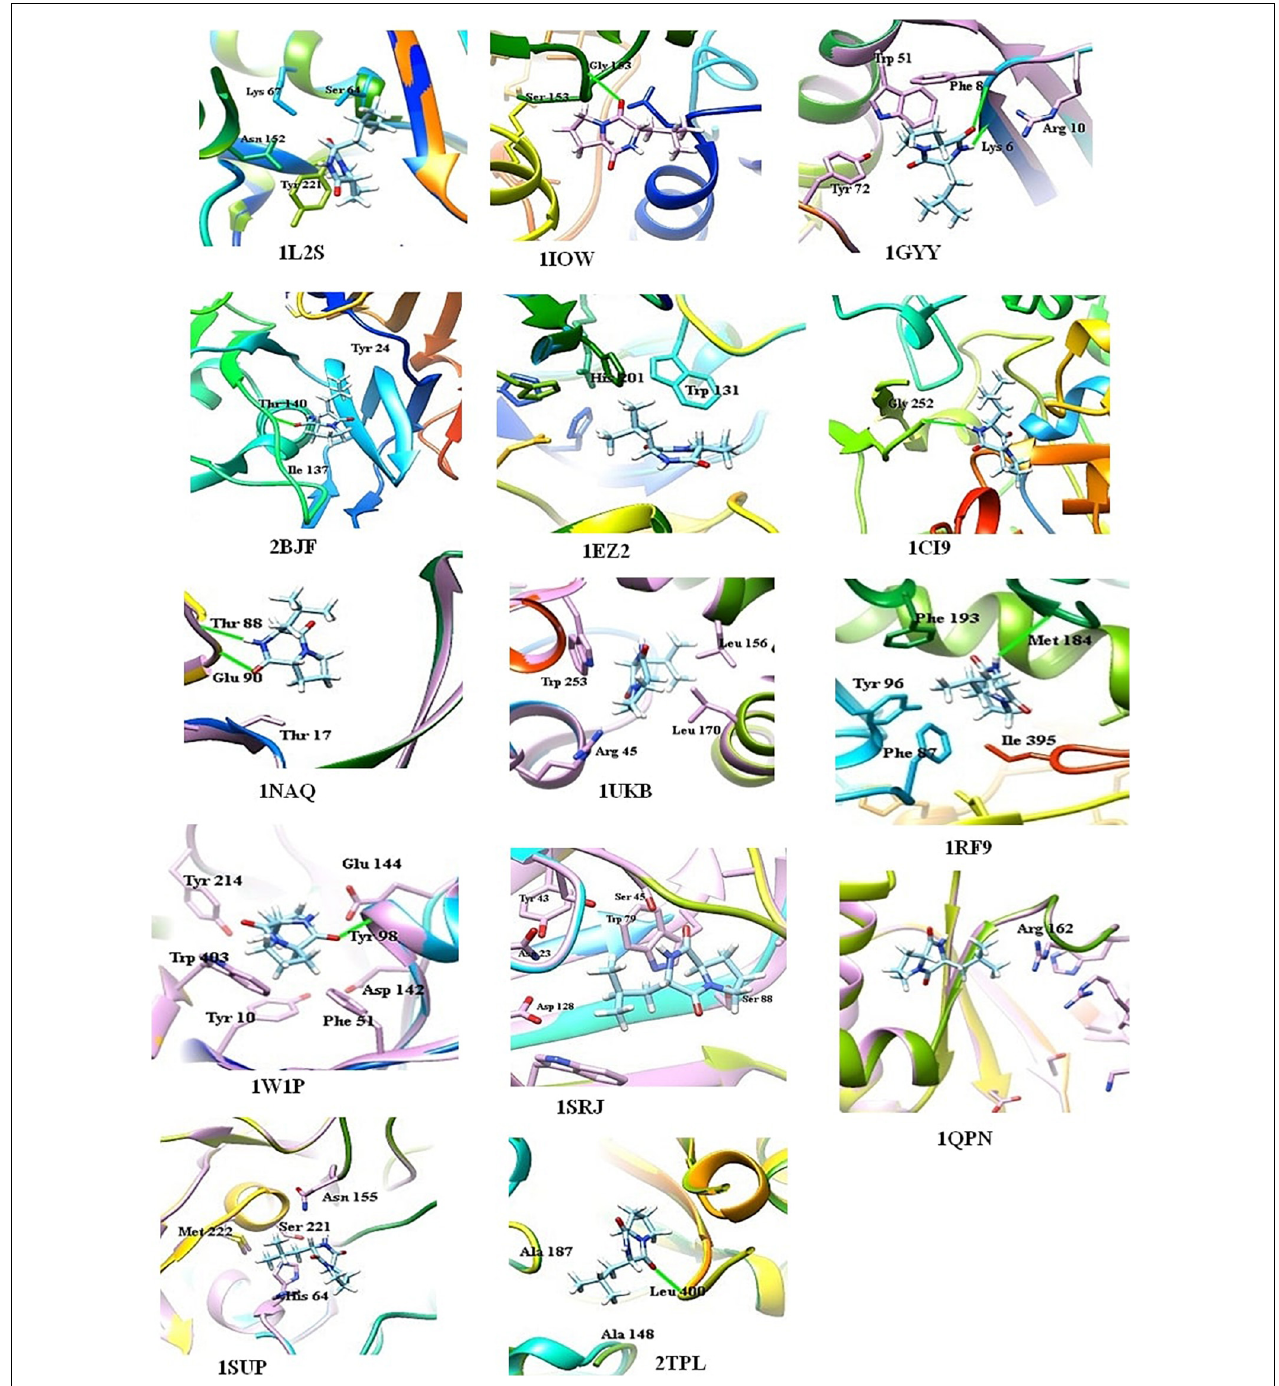
FIGURE 8 | Binding interactions of PPDHMP compound identified in B, seminalis JRBHU6 with predicted targets.